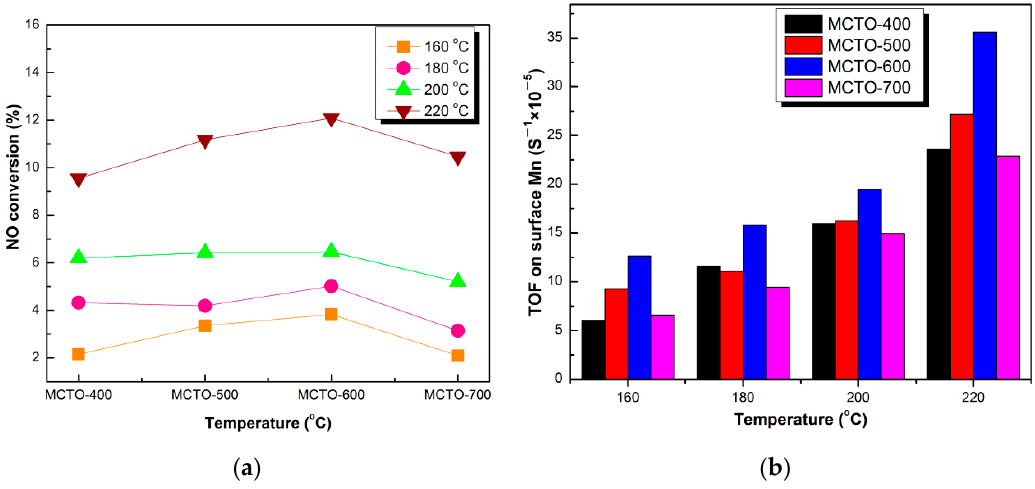
Figure 11. NH 3 –SCR performance ( a ) and the corresponding TOF ( b ) of MCTO-400, MCTO-500, MCTO-600, and MCTO-700 at different temperatures. Reaction conditions: 500 ppm of NO, 500 ppm of NH 3 , 5 vol. % O 2 , balance N 2, catalyst mass = 20 mg, flow rate = 240 mL·min − 1 , GHSV ≈ 200,000 h − 1 .